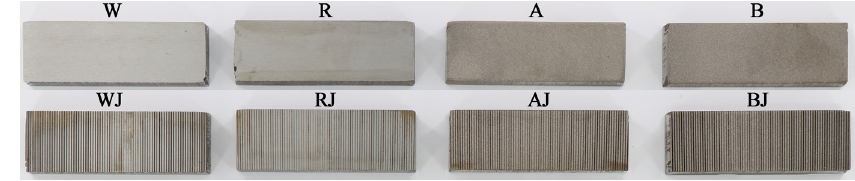
Figure 3. Specimens before the abrasion.